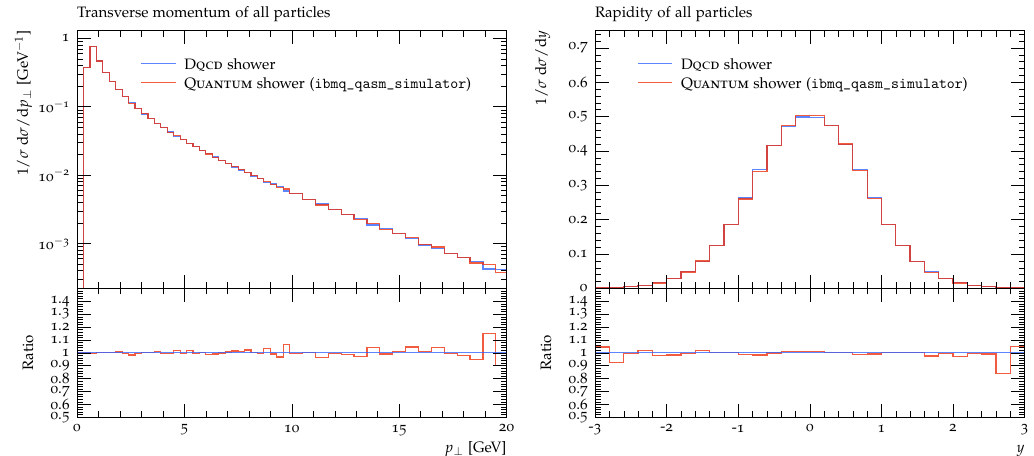
Figure 5. Representative comparison the (classical) Discrete QCD model and Quantum Parton Shower results from the 32-qubit ibmq_qasm_simulator , for the transverse momentum and rapidity of all final-state particles in the synthetic data. As expected from figure 4, the two algorithms match